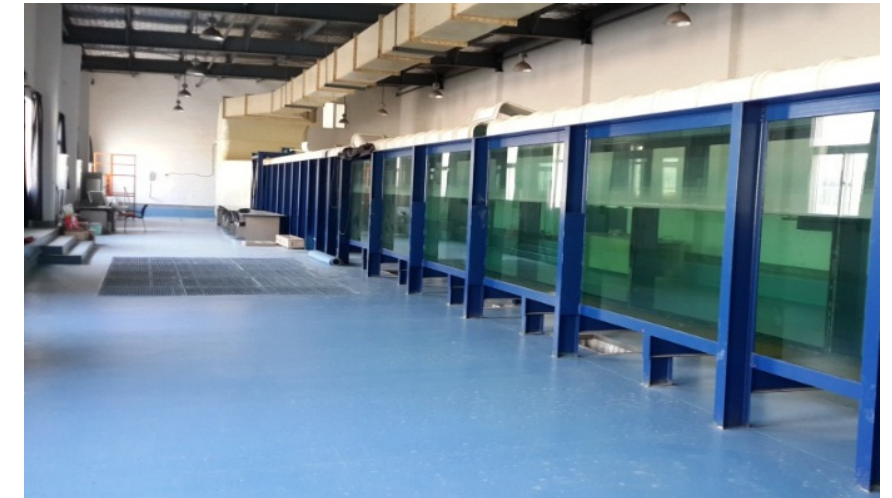
Figure 2. Wind–wave–current multifunctional experimental flume site photo. (2) Underwater